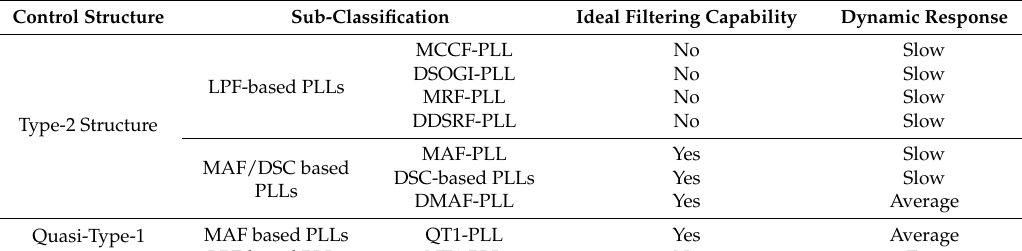
Table 1. Performance comparison between some typical PLLs